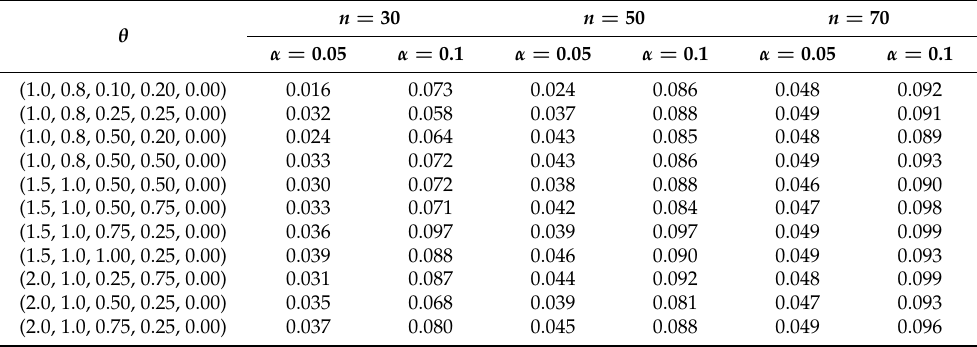
Table 4. Simulation results for the probability of type I error for a 1 = 1 and a 2 =